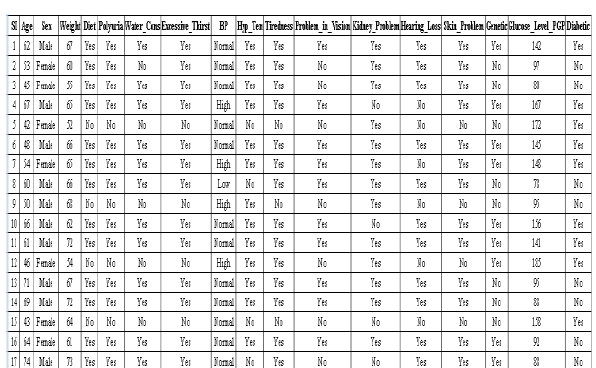
Table 11. Sample dataset of diabetic hearing loss